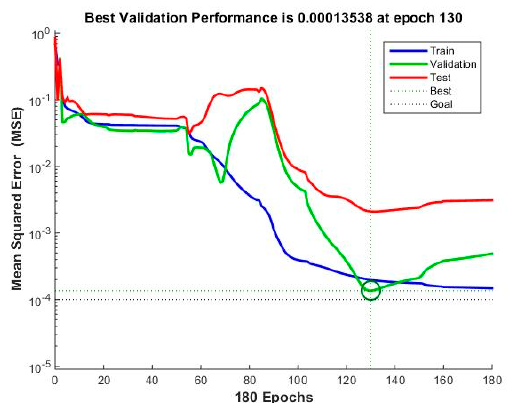
Figure 5. The convergence curve of mean squared error (MSE) with iteration during training the deep neural network (DNN) model.